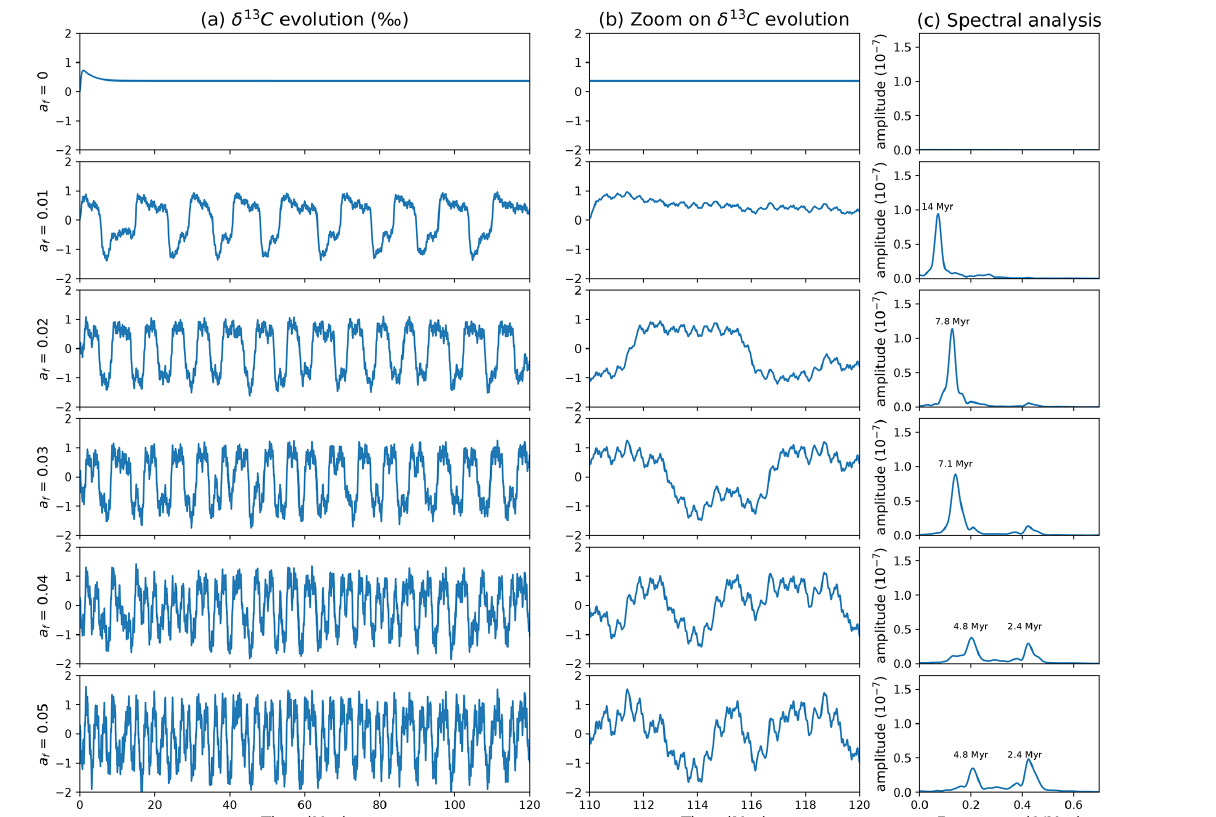
Figure 9. Case B. (a) Modelled δ 13 C for different a f values, and a = 1 . 5 · a lim . (b) Zoom on the last 20Myr of the simulation. (c) Spectral analysis of the modelled δ 13 C.